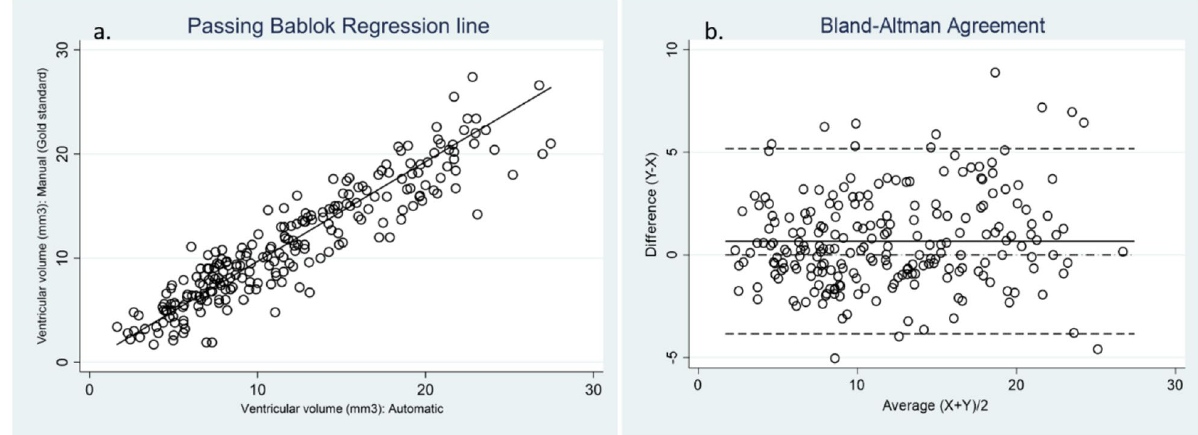
Figure 4. ( a ) The Passing Bablok regression line allows visual inspection of agreement between manual and automatic segmentation. The intercept represents constant differences while the regression line slope represents proportional differences among methods, none of which were significant. ( b ) The observed bias (difference (Y–X)) is 0.61 (SD 2.28) and 94% of the differences are included within the 95% agreement limit (see text for detailed